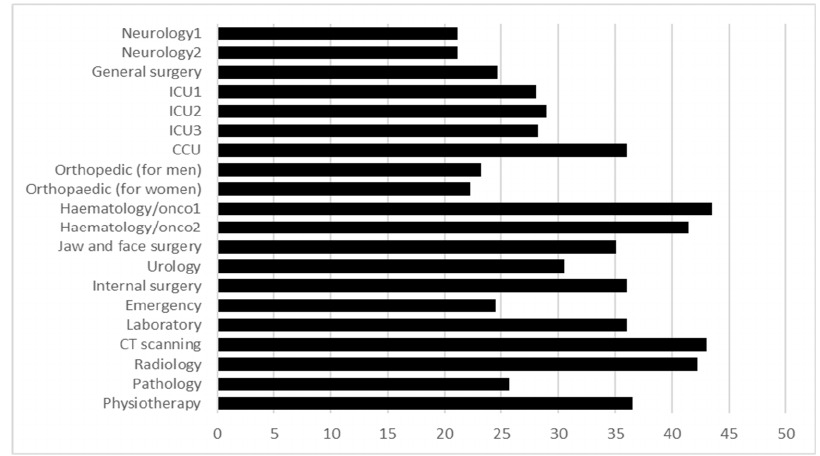
Figure 3. Result of WSM matrix from managerial experts for the rearchitecting of the HF.